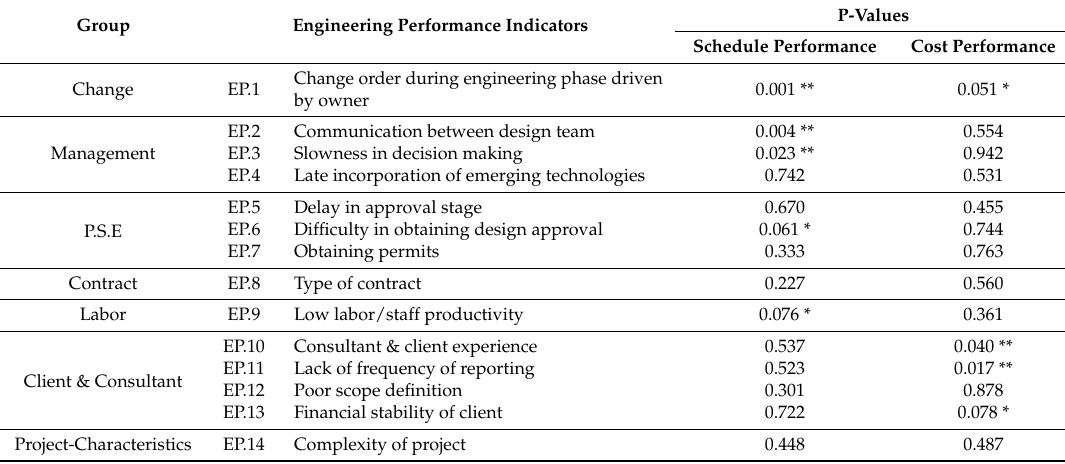
Table 3. Engineering Phase Cost and Schedule Performance